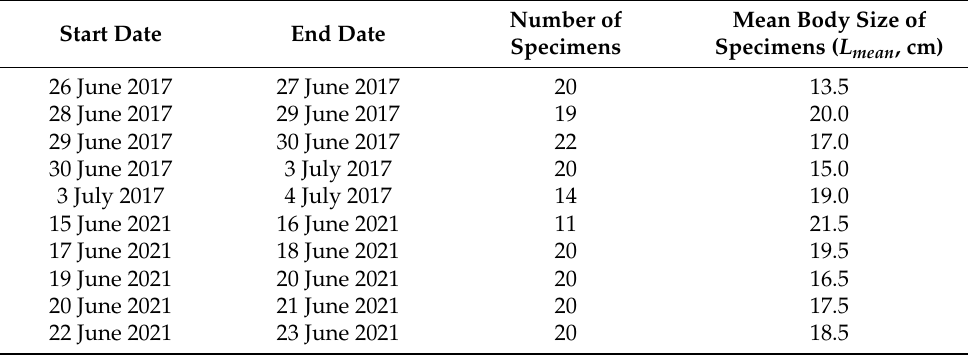
Table 1. Experiment date and fork length composition of experimental fish.